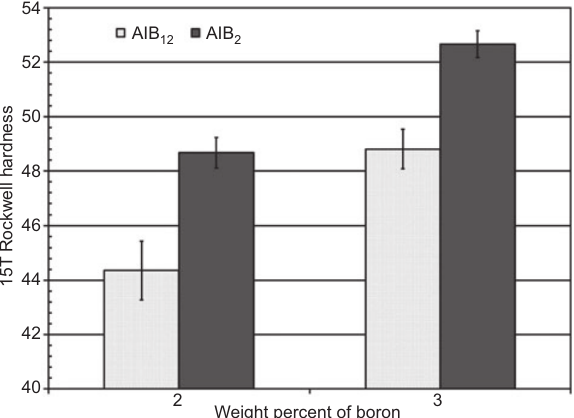
Figure 2 Superfi cial Rockwell hardness of centrifugally cast Al-B-Si